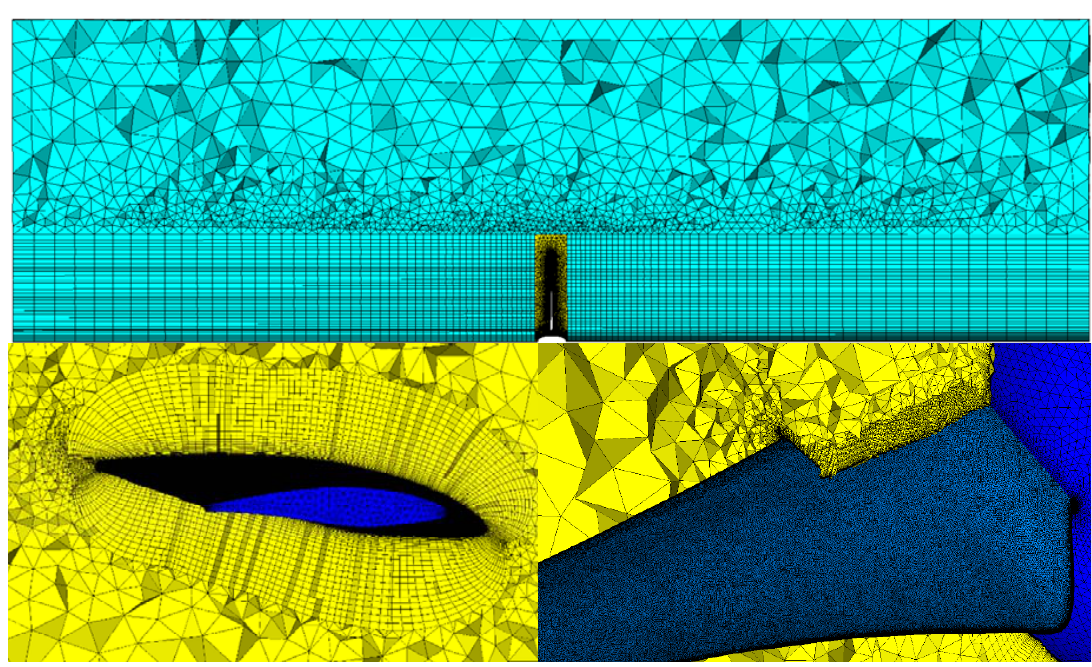
Figure 3. Mesh cross ‐ section views: global (top) and around blade and hub (bottom). Table 2. Flow simulation boundary conditions.